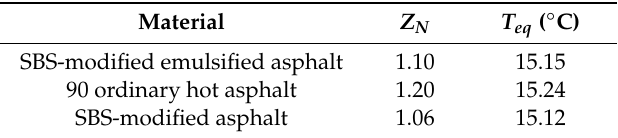
Table 15. Equivalent temperatures of di ff erent waterproof cohesive layer material.